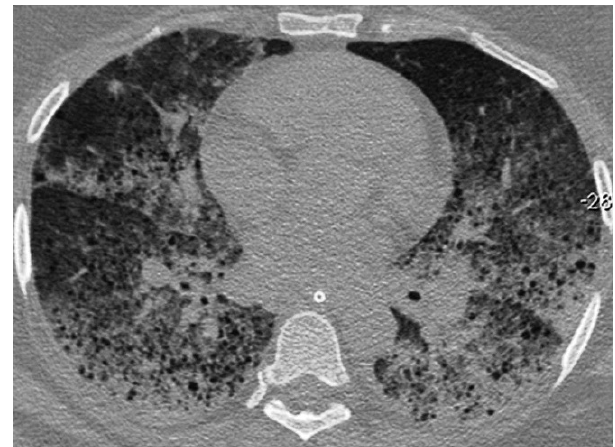
Figure 1 - Thoracic computed tomography. Bilateral and diffuse ground-glass attenuation opacities predominant in the lower lung lobes and thin-walled cystic lesions diffusely distributed in both lungs, as identified using thoracic computed